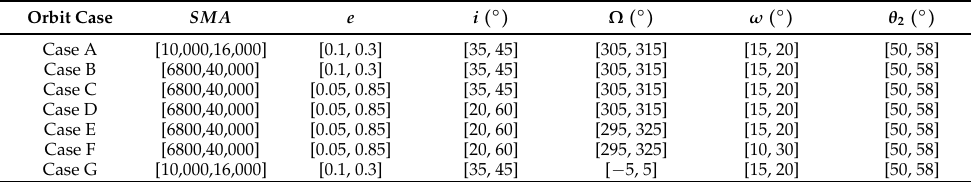
Table 1. Orbital regimes for each case used in GPR